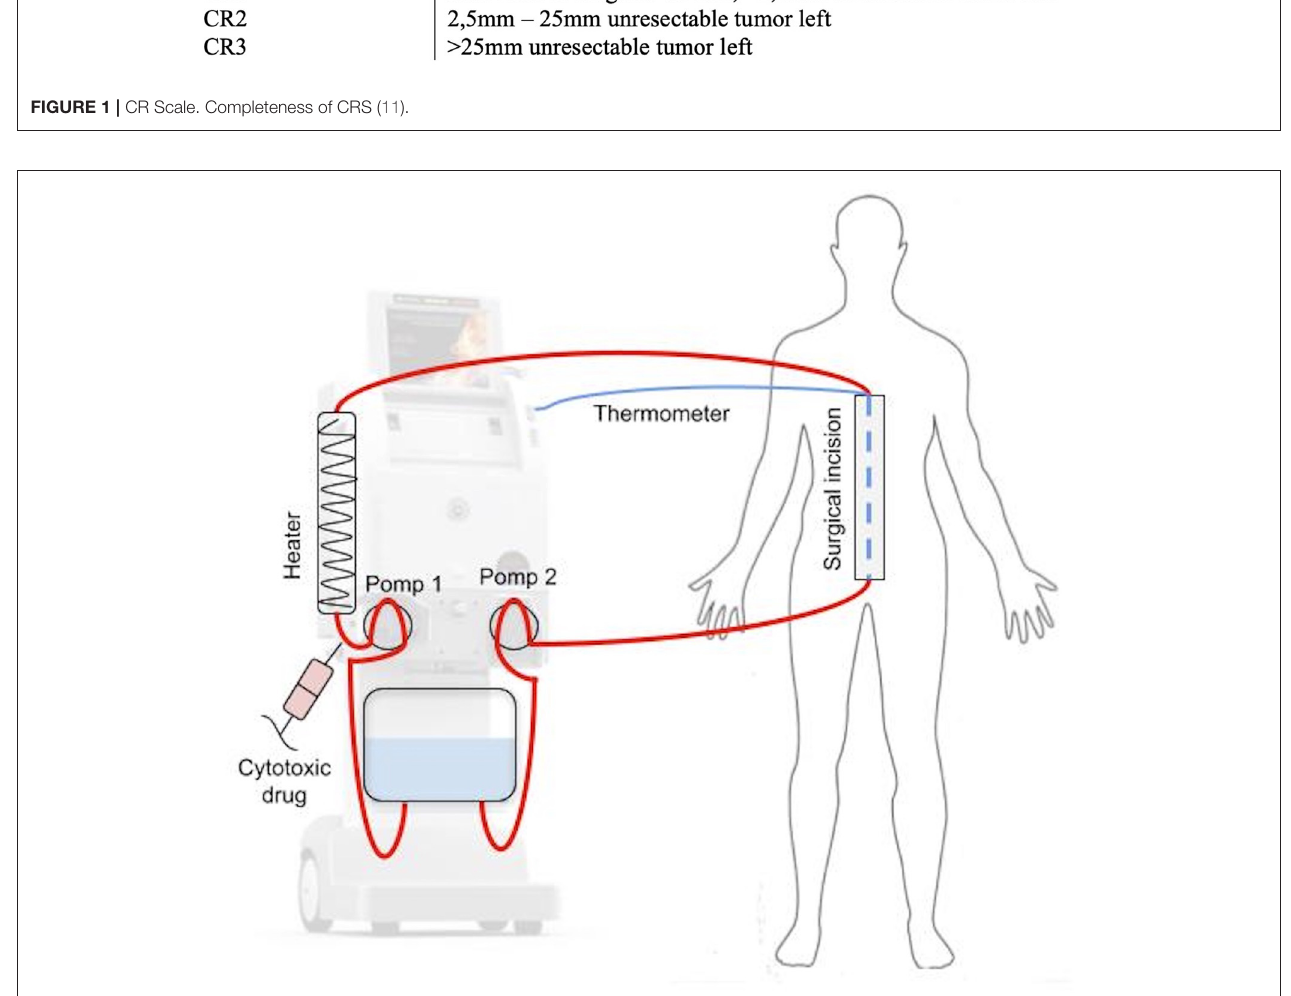
FIGURE 2 | Schematic overview of